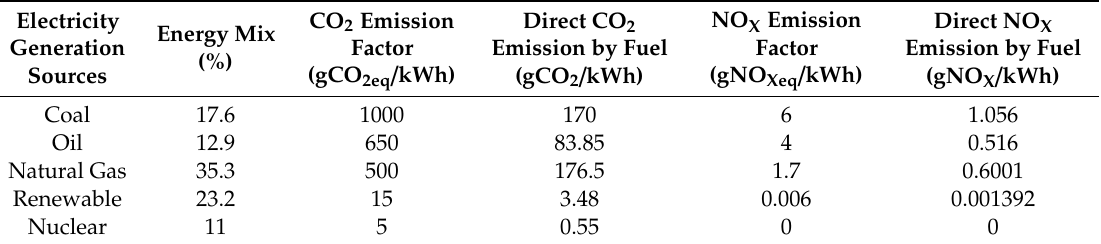
Table 2. CO 2 and NOx emissions intensities, depending on the energy mix for the year 2019